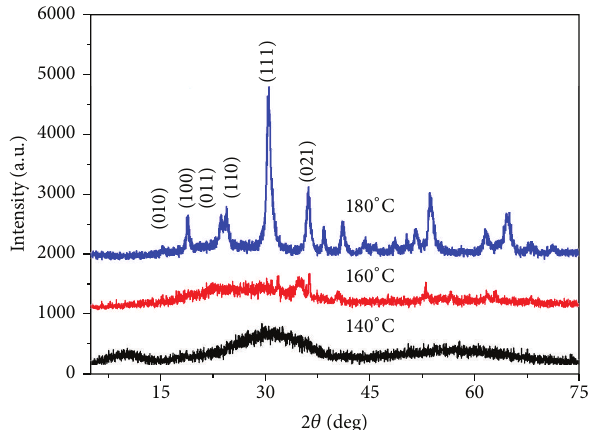
Figure 1: XRD patterns of ZnWO 4 formed at a different reaction temperature for 5min.